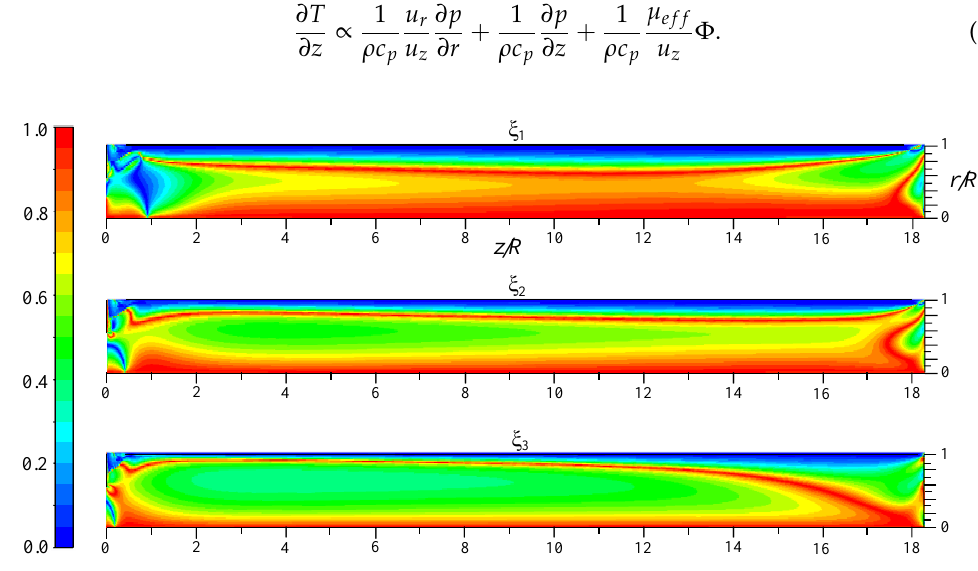
Figure 8. Contours for different cold mass fractions.